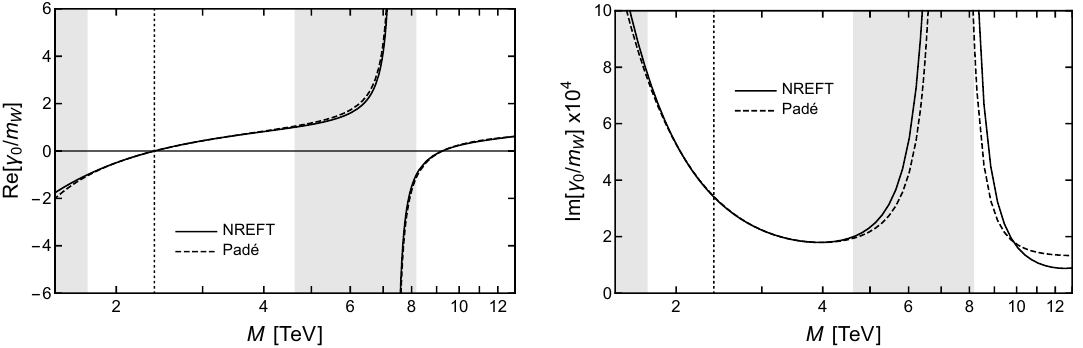
Figure 9 . Real and imaginary parts (left and right panels) of the inverse neutral-wino scattering length (cid:13) 0 = 1 =a 0 as functions of the wino mass M (solid curves). In the left and right panels, the dashed curves are the Pad(cid:19)e approximants in eqs. (3.14a) and (3.14b), respectively. The vertical dotted line indicates the unitarity mass at M (cid:3) = 2 : 39 TeV. The grey regions are the ranges of M in which j (cid:13) 0 j > m W , so a ZREFT for neutral and charged winos is not